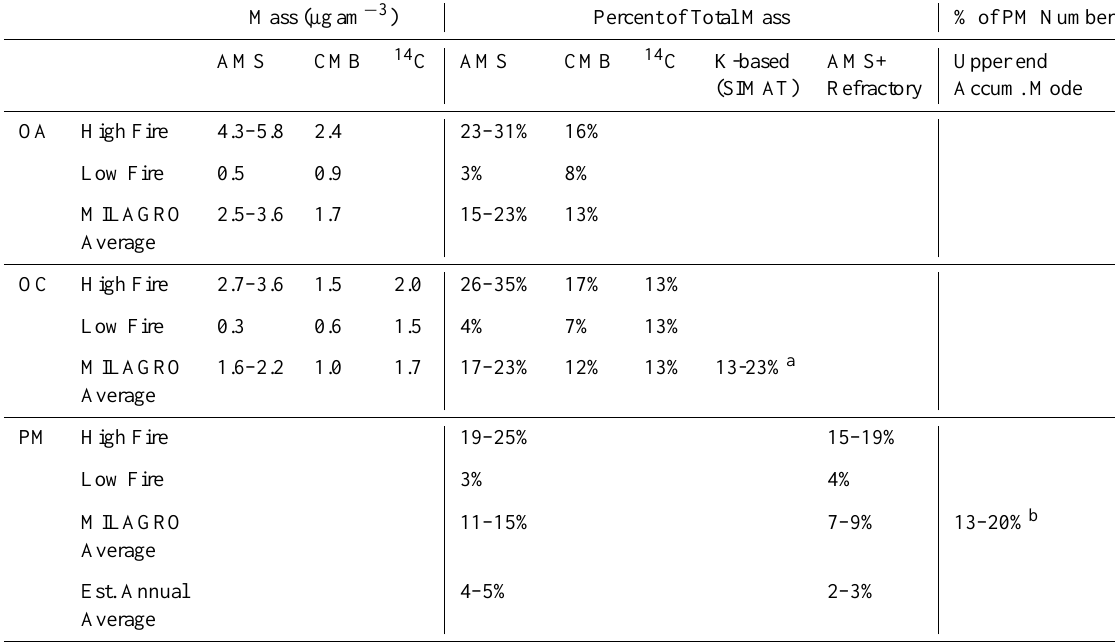
Table 1. Biomass burning contributions to OA, OC, and PM during the high and low fire periods, MILAGRO average, and an estimated annual percentage of fine PM. (AMS + Refractory = AMS + BC + metals +